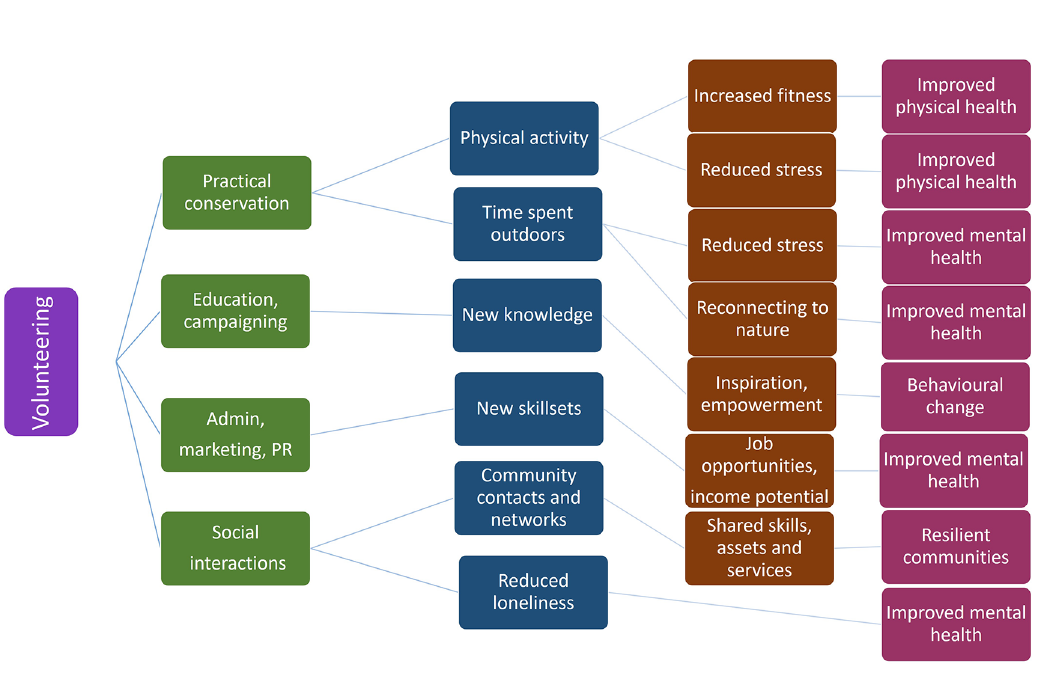
Figure 1. Conceptual flowchart illustrating potential positive impact pathways from volunteering to the participating individual based on theory of change